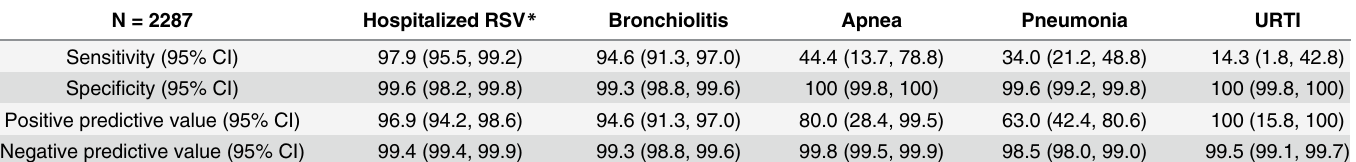
Table 2. Algorithm validation results of full RSV-positive cohort and specific disease pathophysiology against the Canadian Institute of Health Information — Discharge Abstract